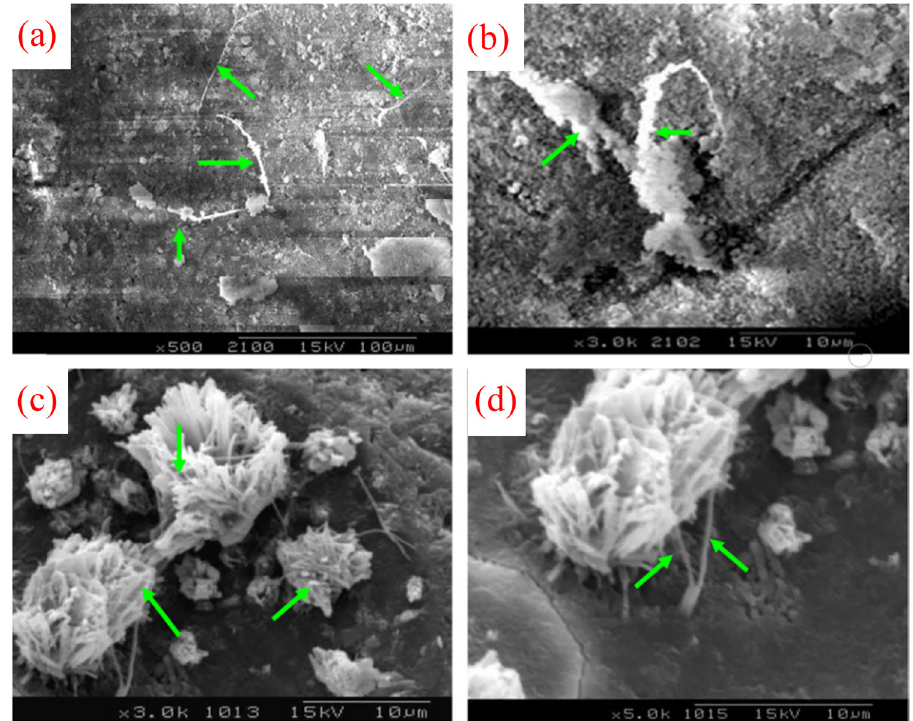
Figure 7: SEM images of CNTCS: ( a and b ) arrows are the morphology of CNT after acidi fi cation and ( c and d ) arrows are the morphology of untreated CNT [ 60 ]